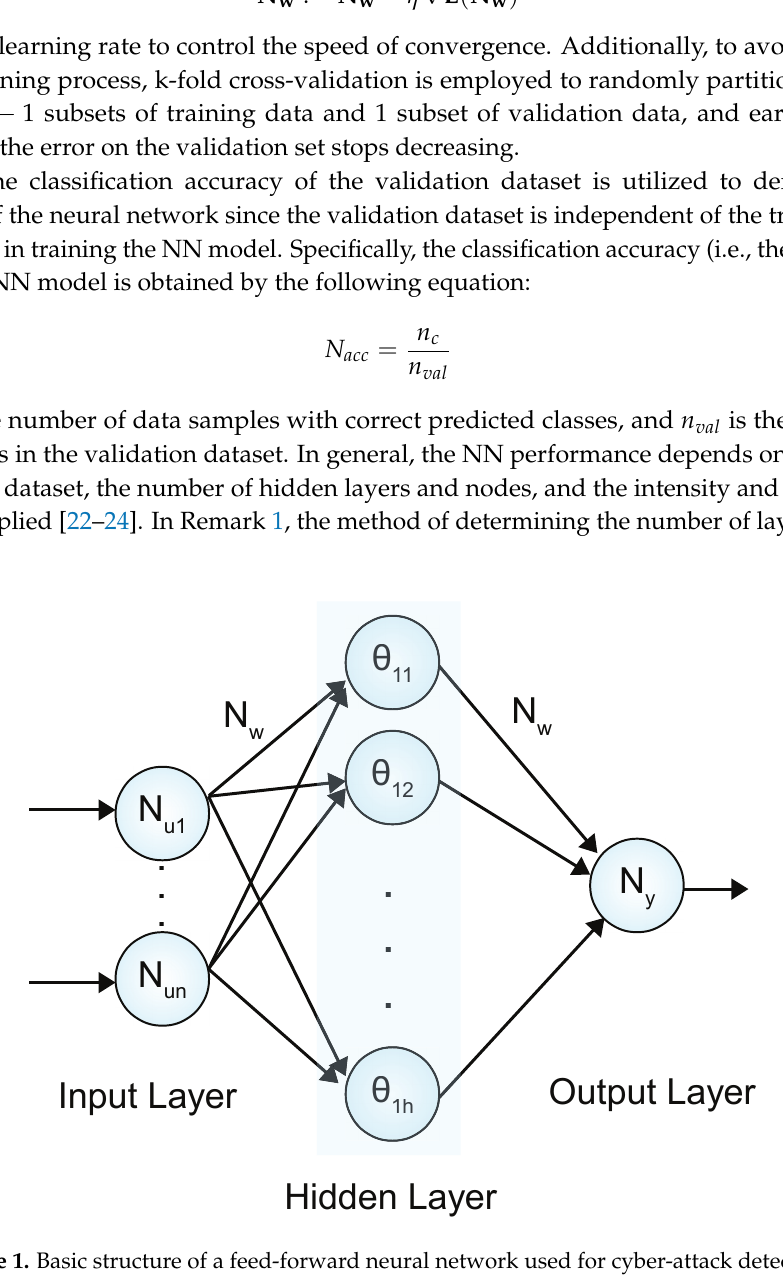
Figure 1. Basic structure of a feed-forward neural network used for cyber-attack